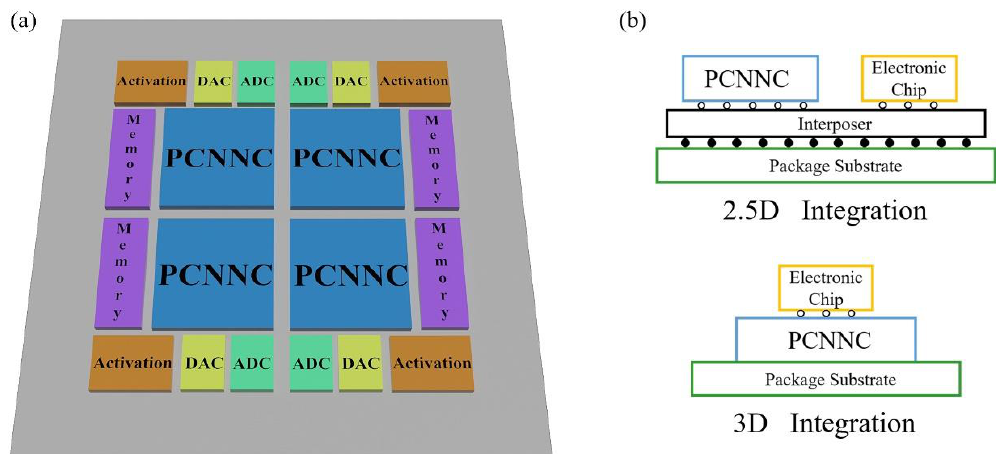
Figure 2. ( a ) The multicore architecture of the PCNN chip. ( b ) Shown are 2.5D integration and 3D integration of the PCNN chip and the electronic chip. PCNNC: photonic complex-valued neural network chip; DAC: digital-to-analog converter; ADC: analog-to-digital converter.